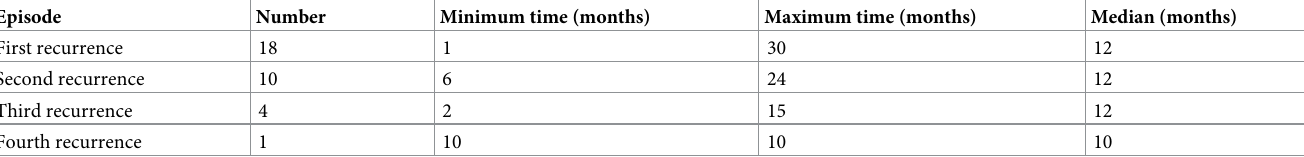
Table 6. Time interval between presentations with crusted scabies in 18 patients with recurrent